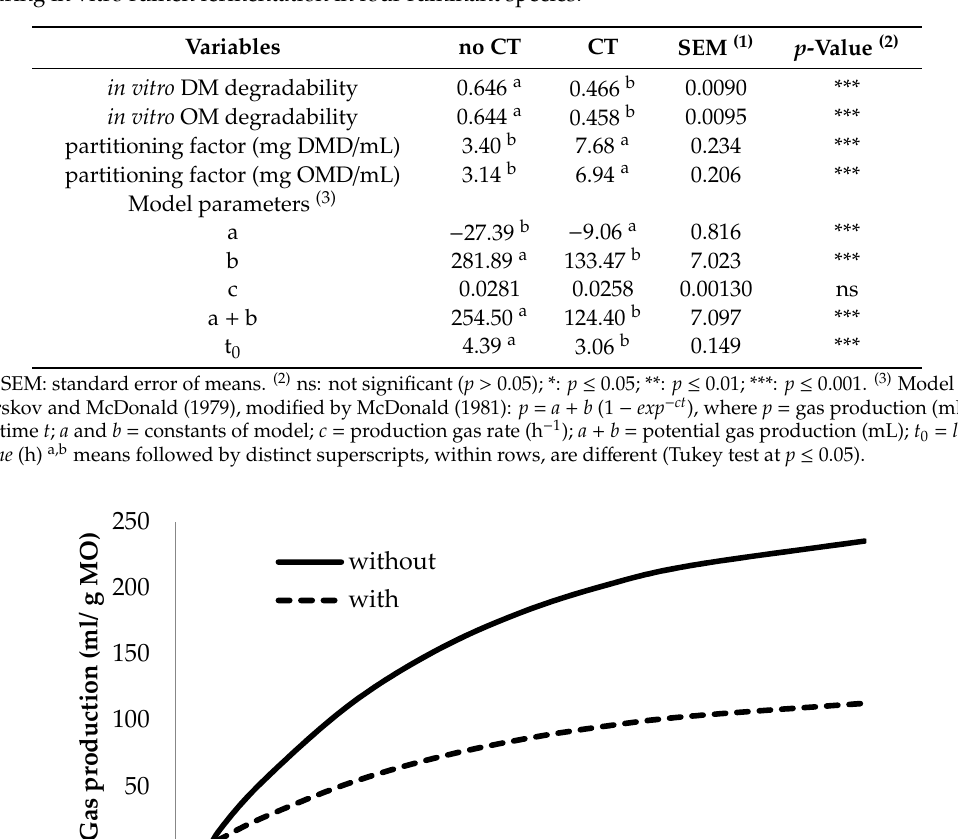
Table 2. Effect of condensed tannins (CT) on degradability, fermentability and microbial efficiency Table 2. E ff ect of condensed tannins (CT) on degradability, fermentability and microbial e ffi ciency during in vitro rumen fermentation in four ruminant species. during in vitro rumen fermentation in four ruminant species.